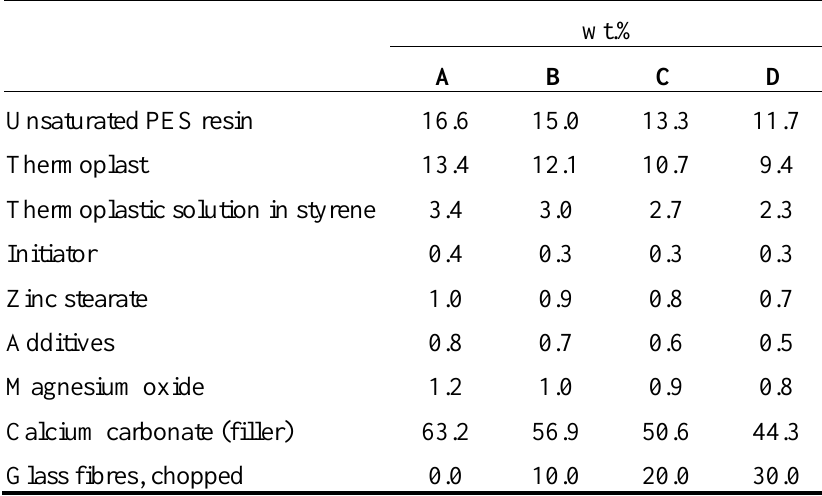
Table 1. SMC Formulations used in the present